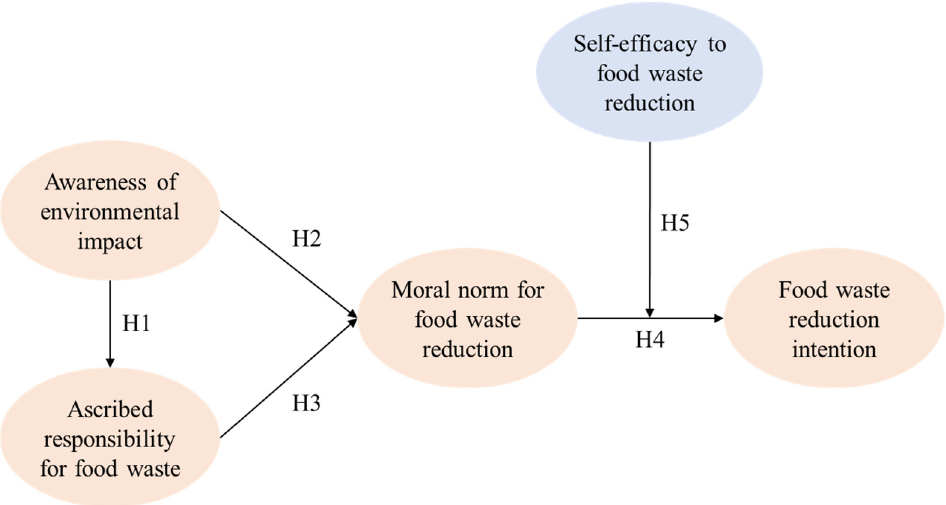
Figure 1. The proposed conceptual